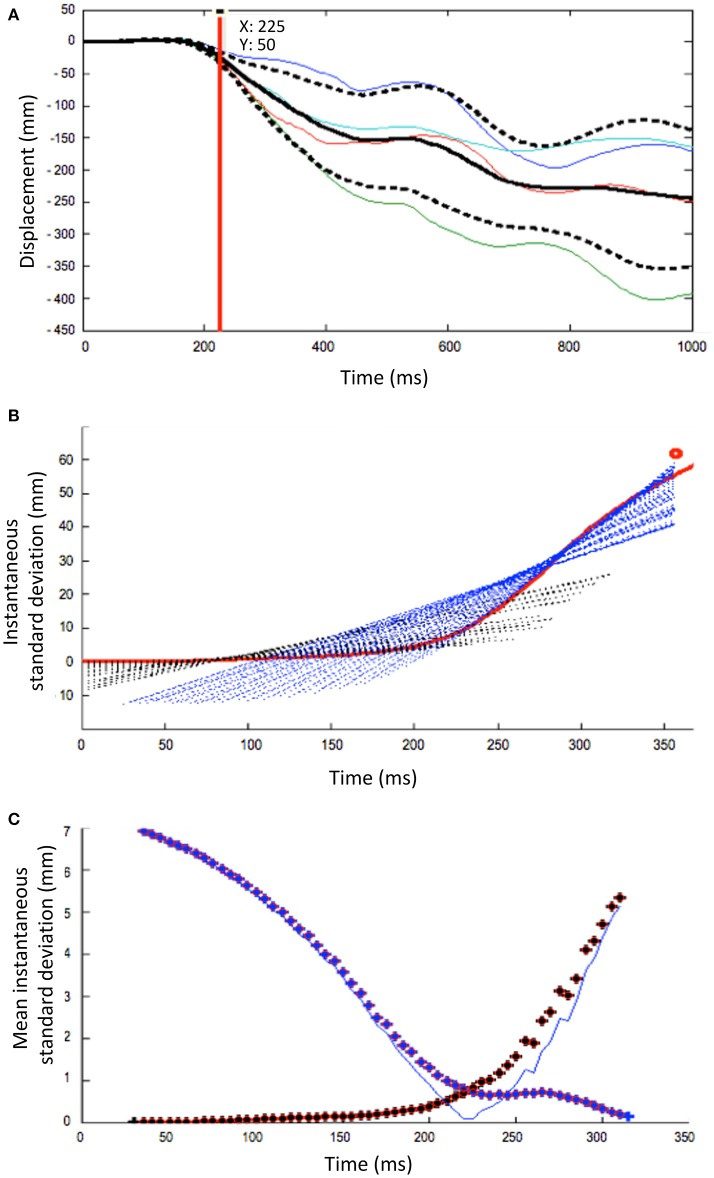
Methodological process to determine the increase of the inter-trial variability at a given condition for a single subject. The illustration is here based on the head segment displacement after a forward fast platform translation. (A) The mean displacement (black solid line) ± 1 s.d. (black dotted lines) is calculated from the superposition of 4 trials (colored solid lines). (B) Instantaneous standard deviation curve against time (mean s.d), as used to determine inflection point (here at about 200 ms). Added are the sliding least-squares lines originating from both sides of the inflection. (C) Determination of the inflection point of the mean instantaneous standard deviation curve (blue squares), from which the inter-trial variability increases significantly (red squares). It corresponds to the intersection point of these lines, which is the minimal value (blue thin line).